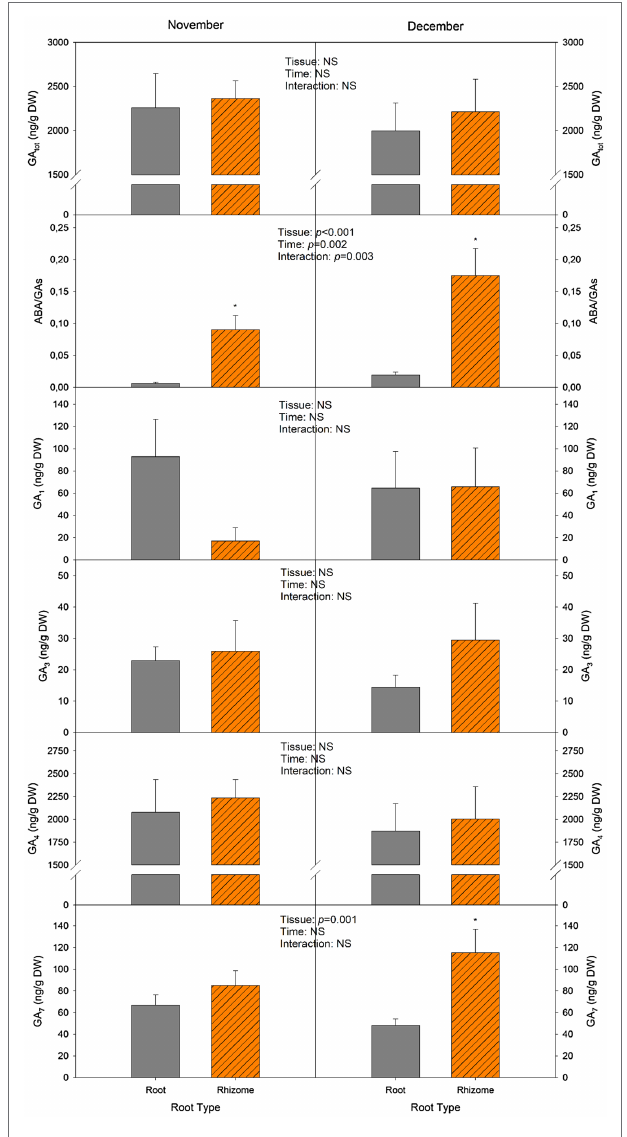
FIGURE 6 | Changes in total gibberellin (GA tot ) contents, ABA-to-GA ratio (ABA/GAs), and GA 1 , GA 3 , GA 4 , and GA 7 concentrations. Measurements were performed in leaves and subterranean organs of I. pseudacorus . Values of p from the two-way mixed factorial analysis are shown, including the factor Time , Leaf type/Tissue , and their interaction. An asterisk indicates differences between leaf types or root tissue types. Data show the mean ± SE of n = 12 individuals. NSL, non-senescent leaf; SL, senescent